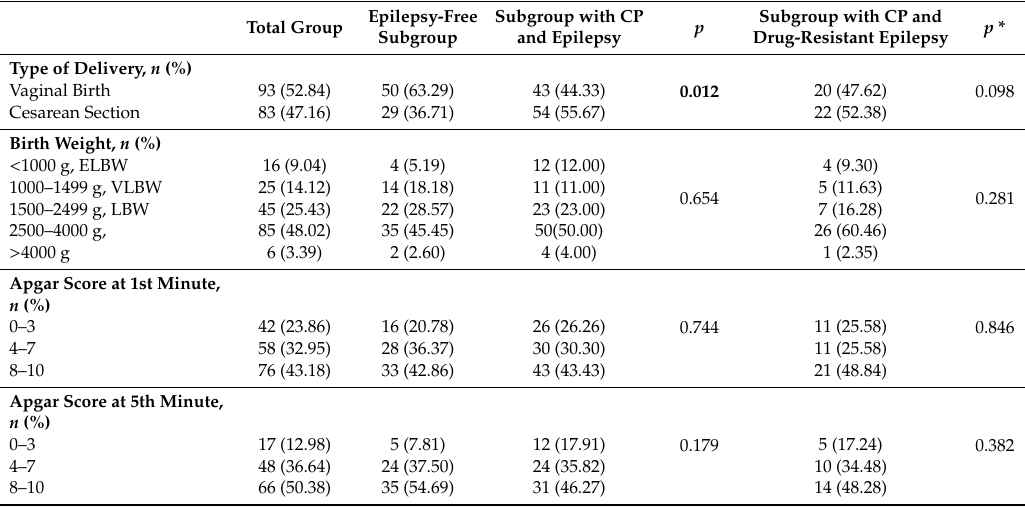
Table 3. Perinatal, neonatal, and infant-related risk factors for epilepsy in CP. Epilepsy-Free Subgroup with CP Total Group Subgroup and